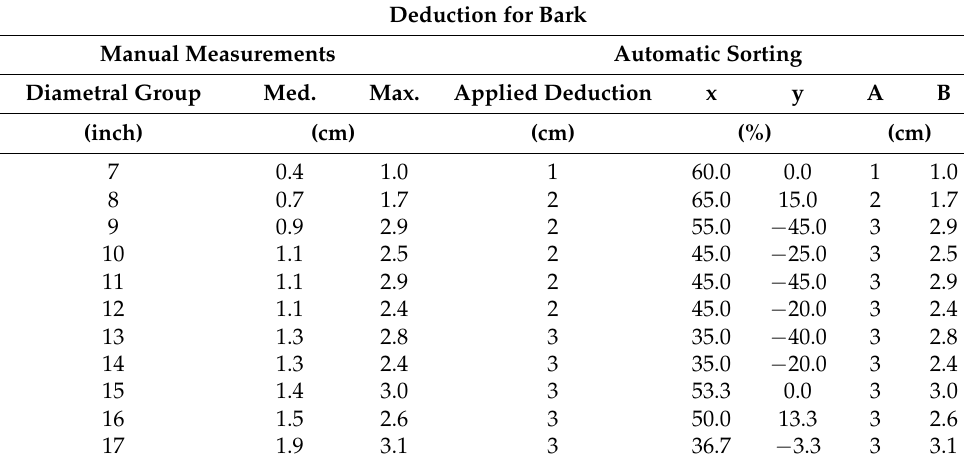
0.89y(med.) y(min.) = 0.02d 12 - 0.414d + 2.218 1 r = Figure 1. The distribution of an average bark thickness in the 7” to 17” sorting ranges. Figure 1. The distribution of an average bark thickness in the 7 ″ to 17 ″ sorting ranges. For the considered range of diameters, the average values of the deduction for the bark can be described by a function y(med.) = − 0.019d 1 2 + 1.611d 1 − 4.917. The coefficient of correlation was characterized by a high value of r = 0.96. Such adjustment of the pa- rameter describing the deduction for the bark assumed for the individual diametral groups was affected by the average value of the standard deviation for the bark meas- urement of 0.2–0.6 cm. The limits of the bark deduction lie within the wide range limited by the following equations: y(min) = 0.02d 12 − 0.414d 1 + 2.218 for the correlation coeffi- cient of r = 0.89 and y(max) = − 0.027d 12 + 0.78d 1 − 2.695 for r = 0.78. Table 4. The adjustment of the bark thickness in automatic measurements with the bark deduction according to modified PN-D-9500 [43]